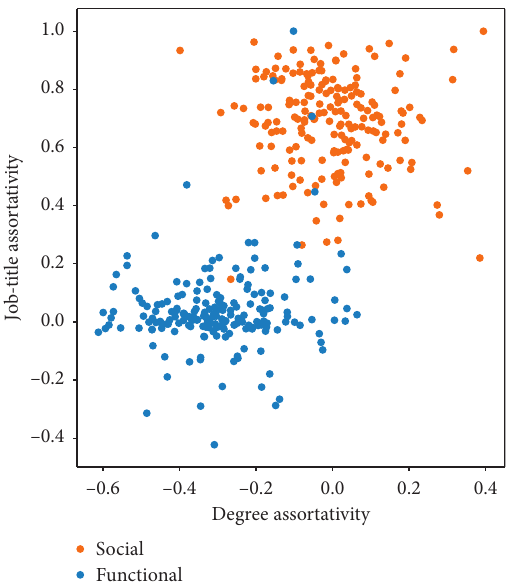
Figure 1: Degree and job-title assortativity coefficients of func- tional and social communication networks for all enterprises. Each company is shown by two dots representing functional (blue) and social (orange) communication networks. Negative degree assor- tativity indicates asymmetry of interactions, and positive job-title assortativity indicates segregation by